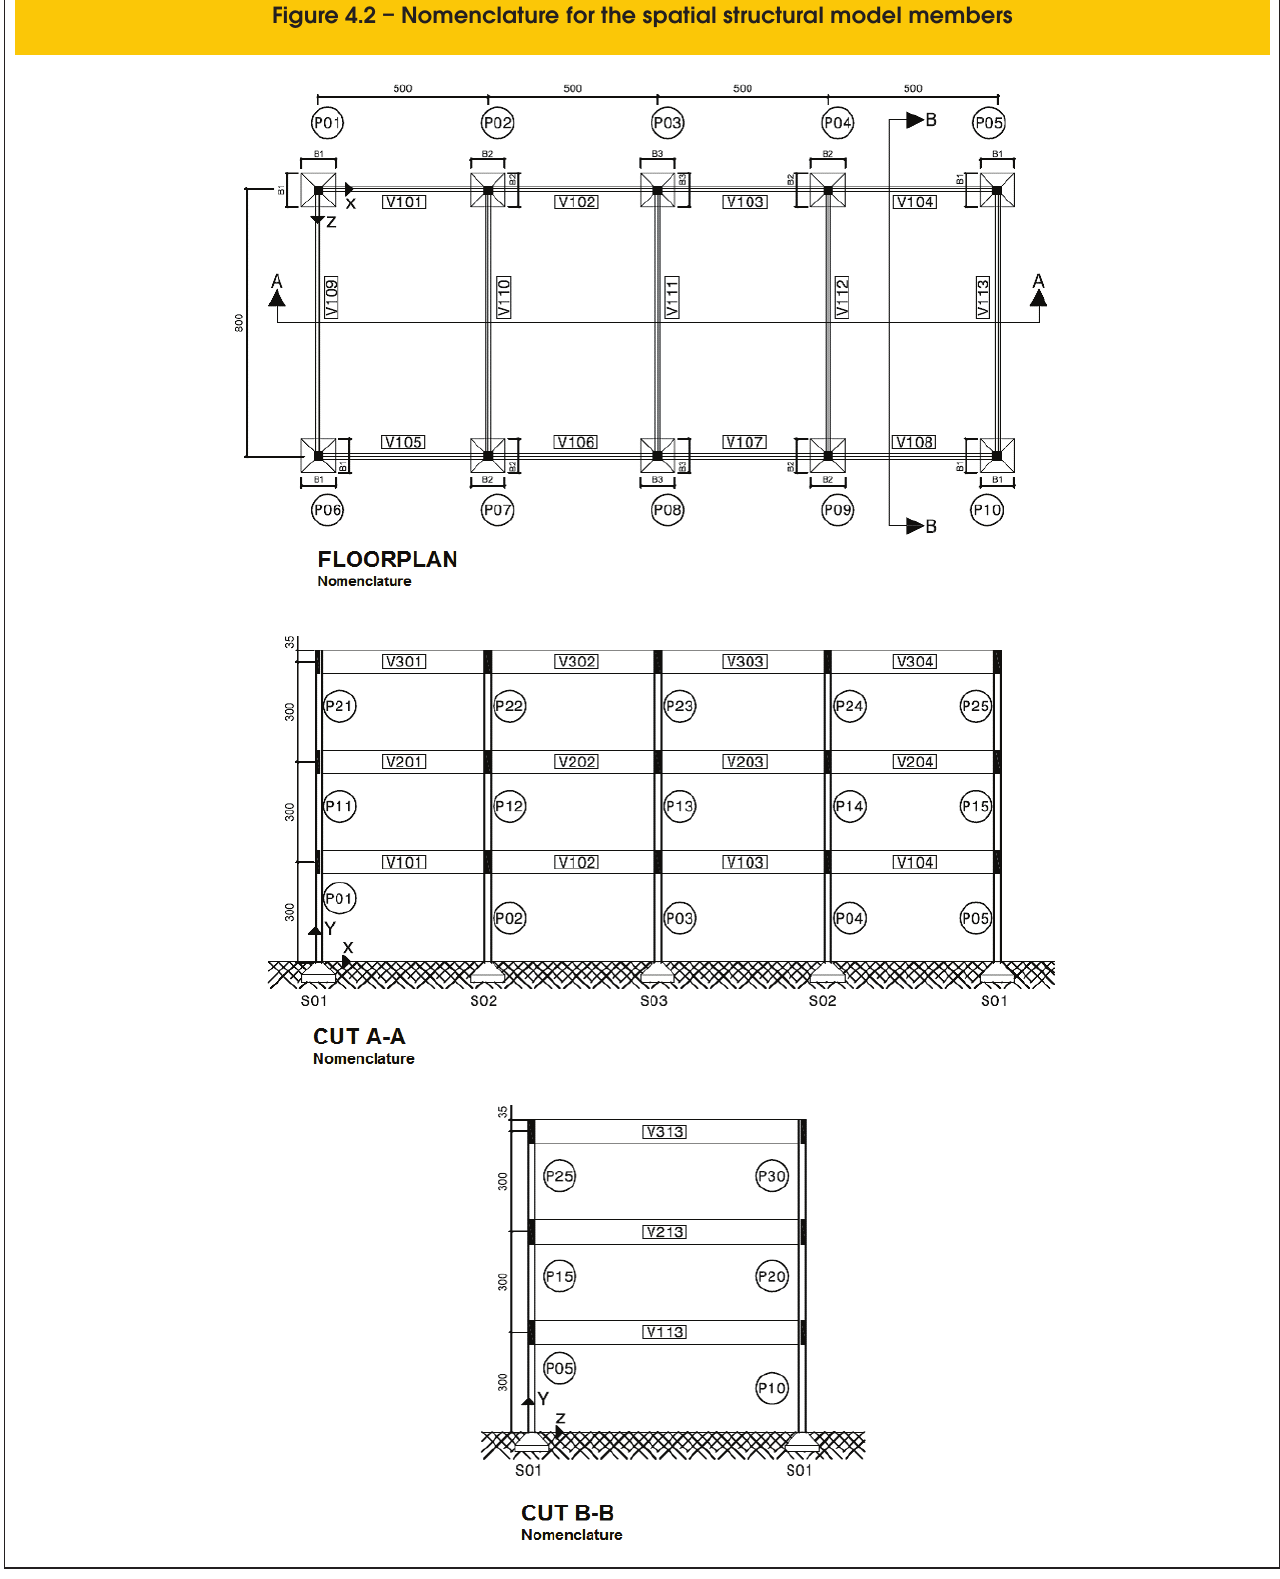
Figure 4.2 – Nomenclature for the spatial structural model